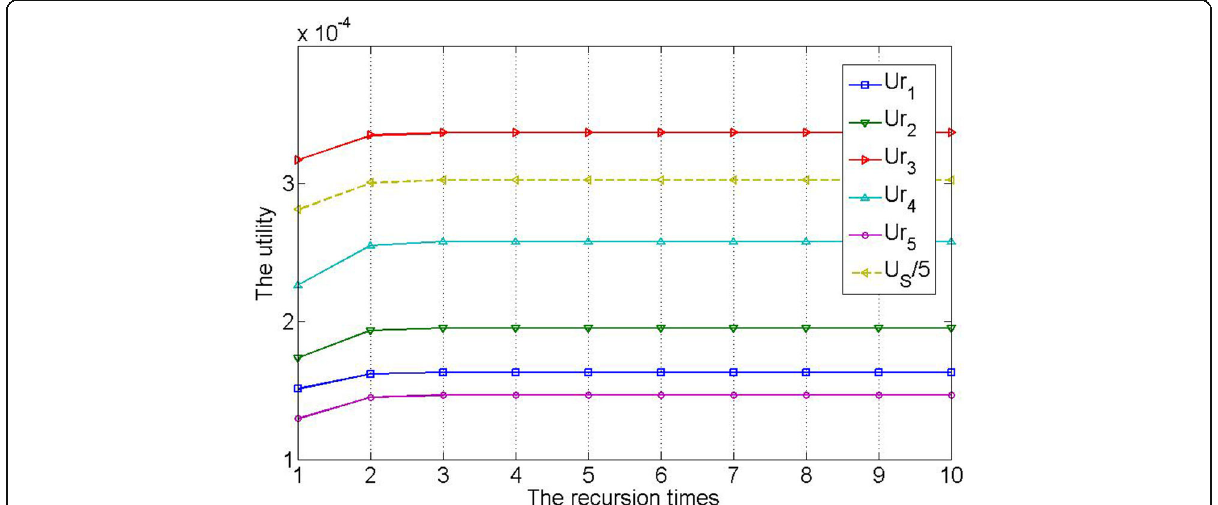
Fig. 3 The utility function gradually converge with the